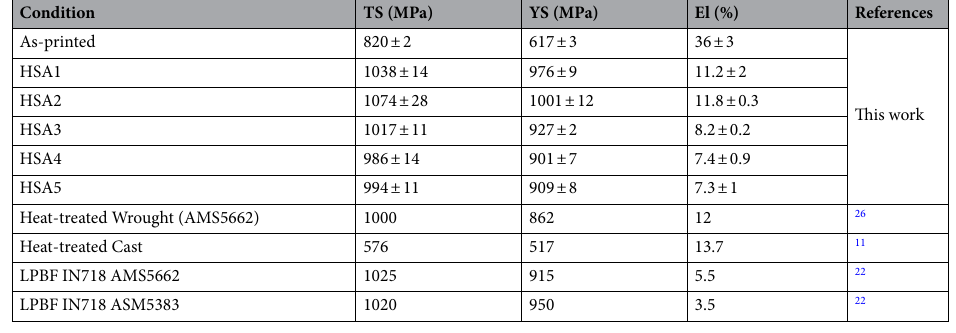
Table 2. Elevated-temperature (650 °C) tensile strength (TS), yield strength (YS) and elongation to failure (El) values of the as-printed and heat-treated conditions. The elevated-temperature (650 °C) tensile properties of the connectionally heat-treated (AMS) IN718 fabricated by LPBF, wrought and cast routes, reported in the literature 11,22,26 , are included for